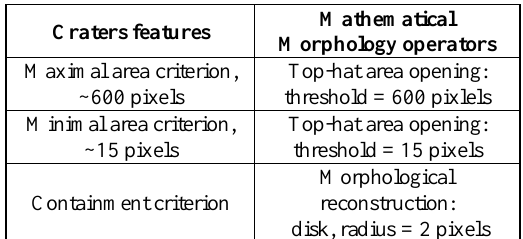
Figure 3. Example of objects which did not fulfill the shape criterion, (a) "illuminated" regions; (b) 'shaded'